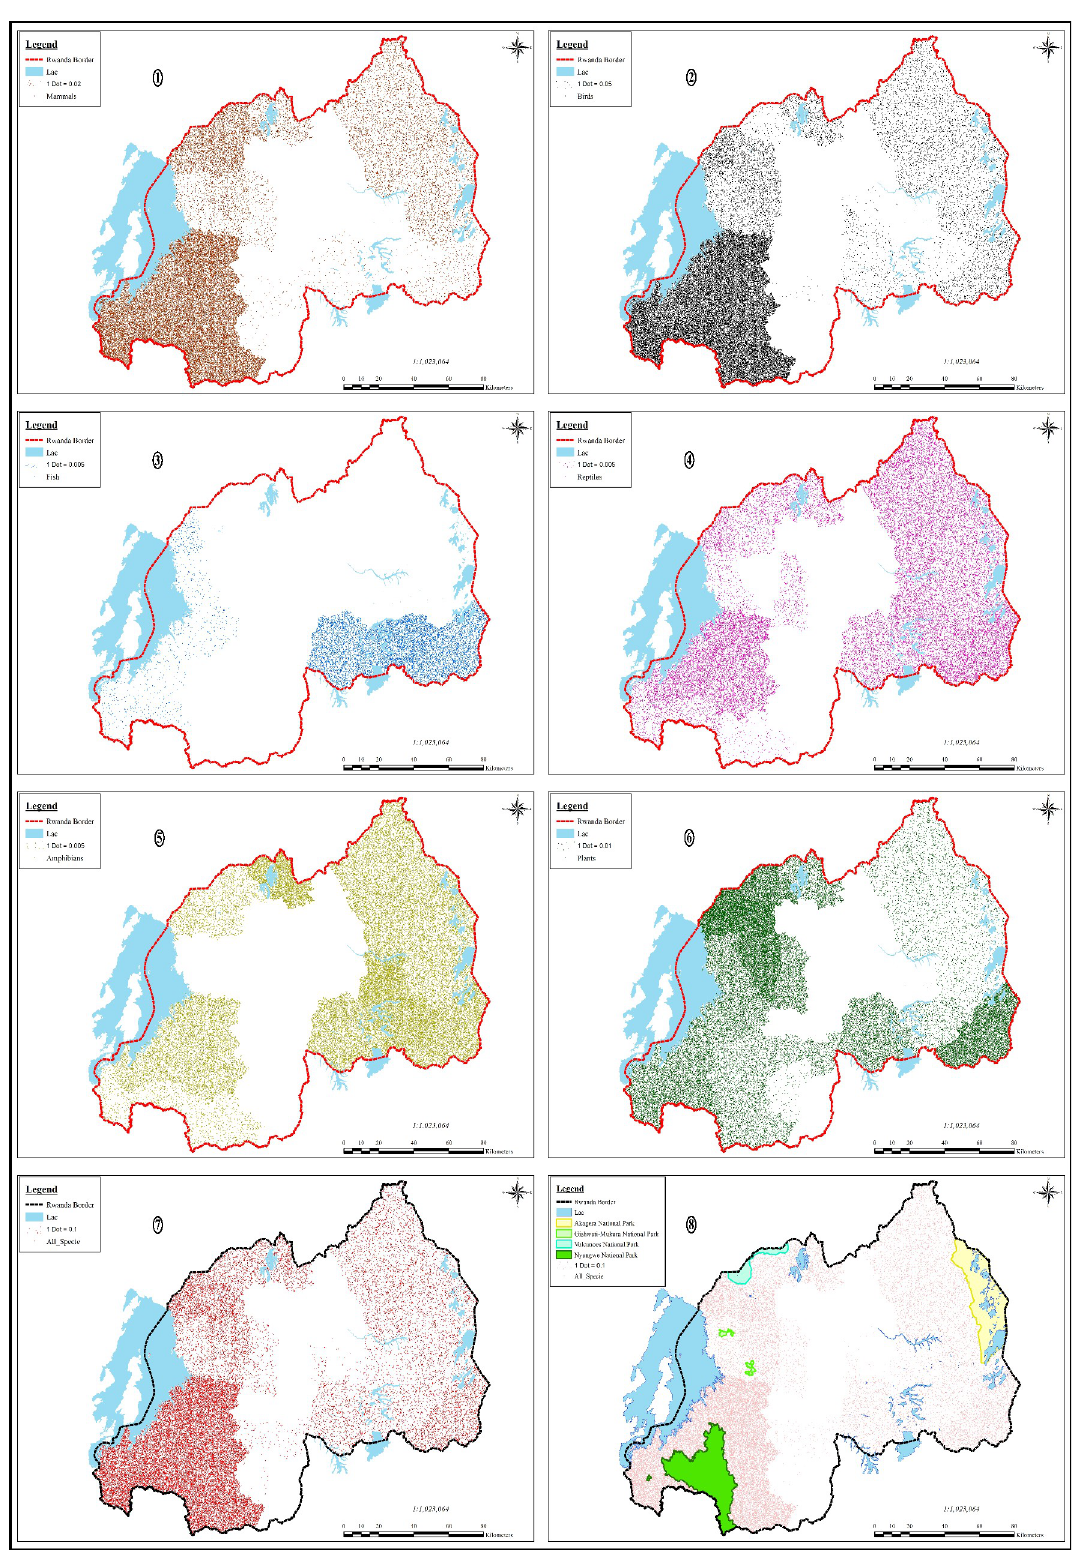
Fig 2. The biodiversity geographic distribution and richness by taxonomic group: ① Mammals, ② Birds, ③ Fish, ④ Reptiles, ⑤ Amphibians, ⑥ Plants, ⑦ All species, ⑧ PA.